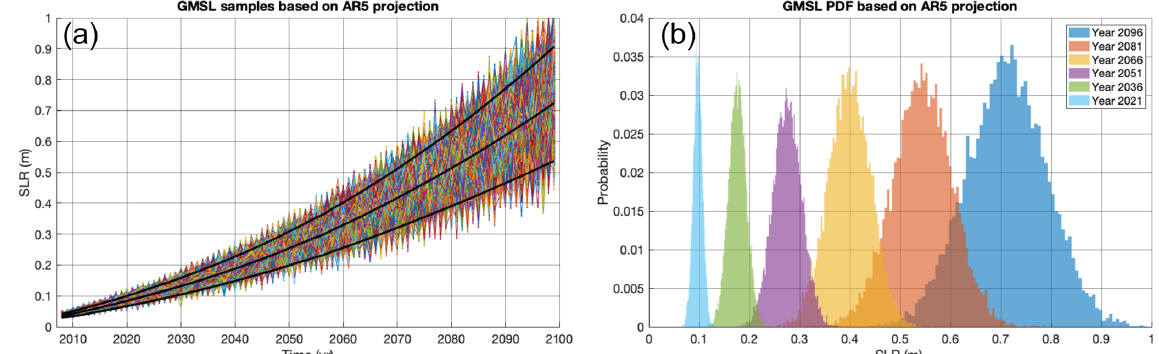
Figure 9. ISSM-SLPS projections based on Intergovernmental Panel on Climate Change Fifth Assessment Report (IPCC AR5) Represen- tative Concentration Pathway 8.5 (RCP8.5). For each time step, we sample (10000 times with Latin hypercube sampling, or LHS) the following inputs: H GIS , H AIS , thermal expansion of the ocean (STR), H TWS and glacier contributions H GLA (see AR5 WG1 chap. 13; Church et al., 2013b). Each input’s PDF is calibrated using the AR5 5%–95% projection confidence interval, similar to Kopp et al. (2014). The resulting global mean sea-level (GMSL) probability distribution function (PDF) distribution is shown in panels (a) (in time) and (b) (at a subset of time steps). The 5%–95% confidence interval (likely range, following AR5 definition) is plotted in black in panel (a) , along with the temporal mean. Each time step is fully decorrelated from the previous time steps, with this test being used to validate against existing